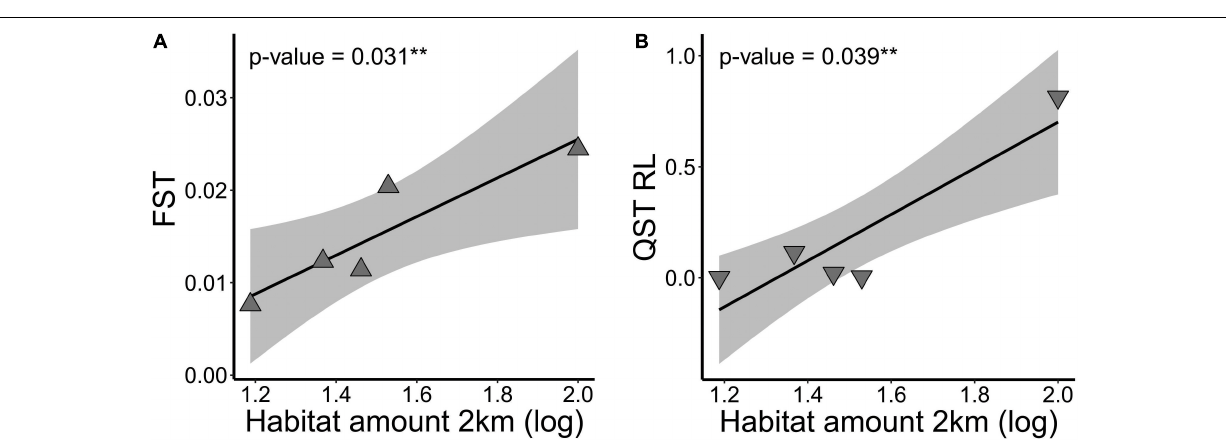
FIGURE 4 | Relationship of (A) genetic differentiation at neutral loci ( F ST ) and at (B) adaptive quantitative trait ( Q ST ) root length (RL), and habitat amount at 2 km spatial scale in five landscapes of Tabebuia aurea in the Brazilian Cerrado. Black line is the linear regression fit and shaded area is the 95% confidence interval. Fits were significant ( p <